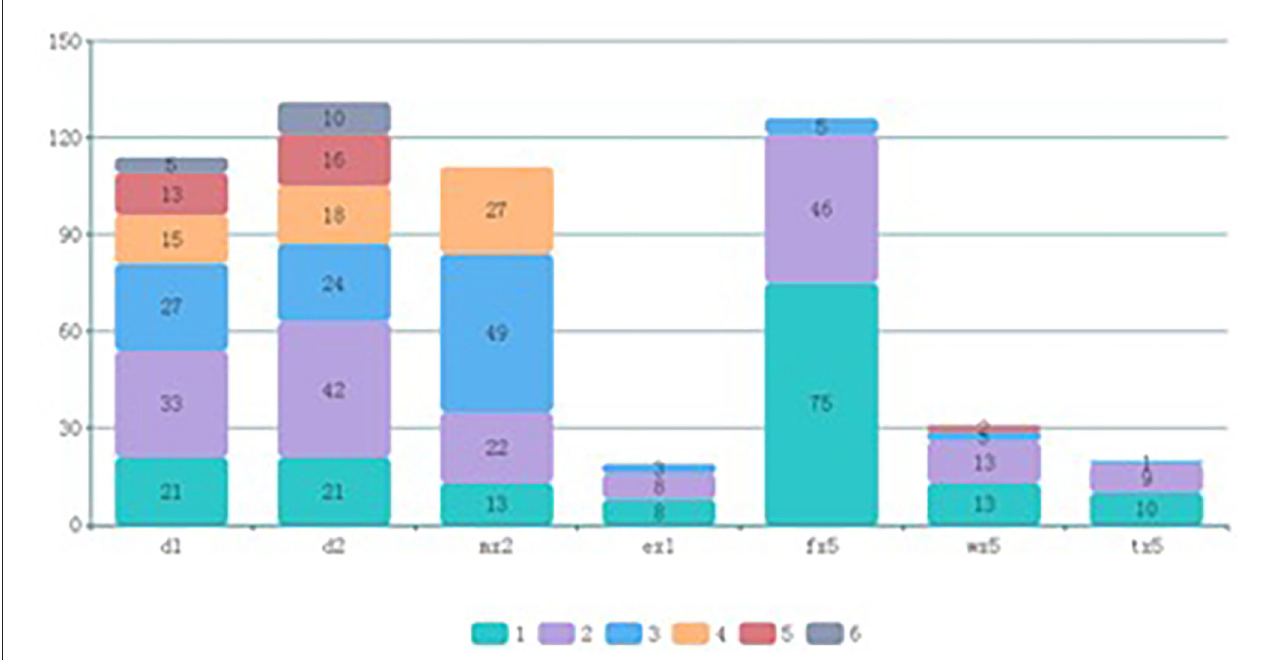
FIGURE 2 | Types and grades of allergens in positive participants. d1, D. pteronyssinus; d2, D. farina; mx2, A. alternata; ex1, dander; fx5, food mix; wx5, mugwort; tx5, willow.